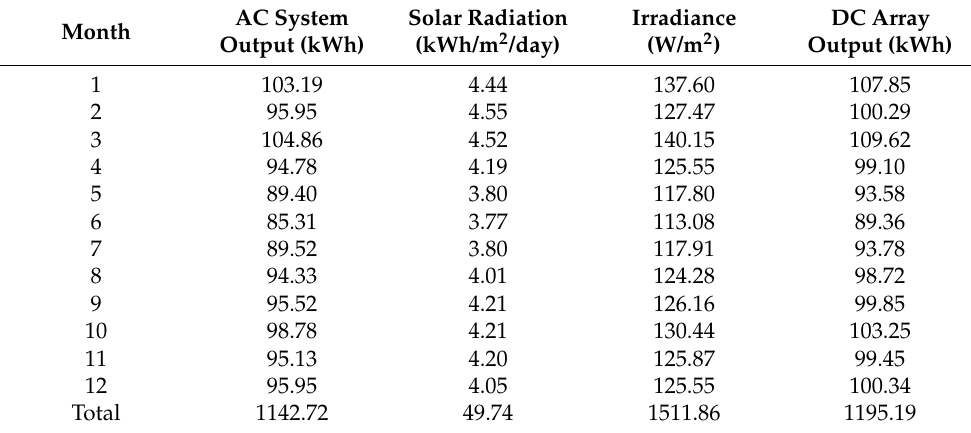
Table 4. Monthly global solar irradiation and the output of a 1 kW PV